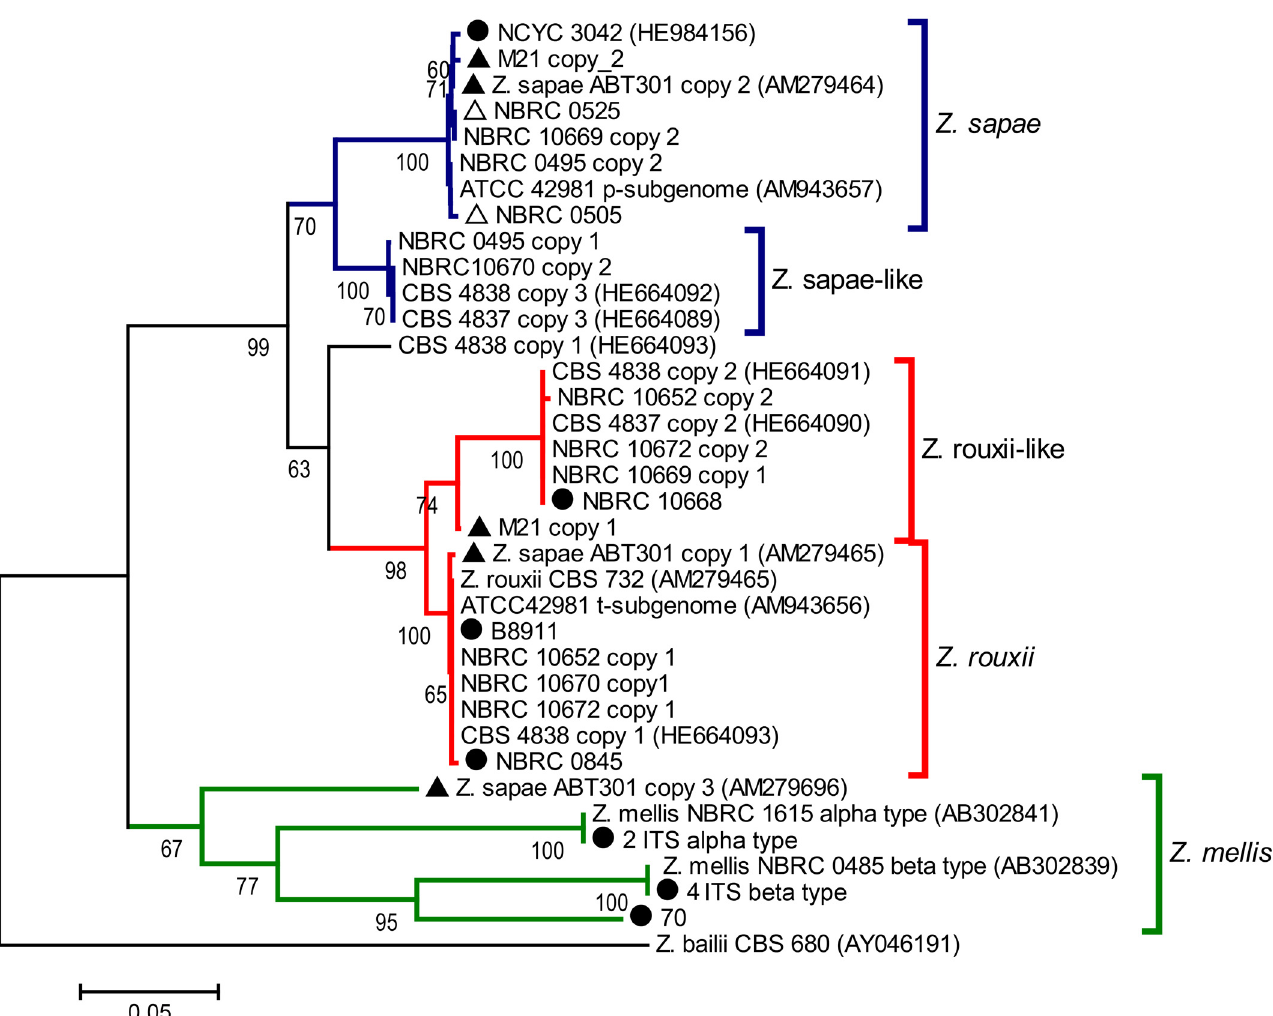
Fig 2. Phylogenetic relationships within the Z . rouxii complex inferred from ITS sequences. This phylogeny was inferred through the Neighbor- Joining method using the ITS sequence of Z . bailii CBS 680 T (GenBank accession number AY046191) as outgroup. The percentage values of replicate trees in which the associated taxa clustered together in the bootstrap test (10,000 replicates) are shown next to the branches (only values higher than 60% are reported). The evolutionary distances were computed using the Tamura-Nei method [47]. The tree is drawn to scale, with branch lengths in the same units as those of the evolutionary distances used to infer the phylogenetic tree. All positions containing gaps and missing data were eliminated. Z . rouxii and Z . rouxii -like clades are colored in red, Z . mellis clade in green, and Z . sapae and Z . sapae -like clades in blue. Black triangles represent strains with homogeneous 26S rDNA D1/D2 domains and heterogeneous ITS regions. Black circles indicate strains without any rDNA heterogeneity. White triangles indicate strains with heterogeneous 26S rDNA D1/D2 domains and homogeneous ITS rDNA regions.